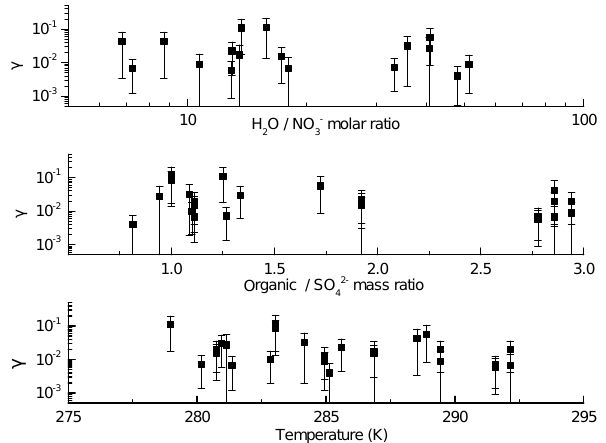
Figure 10. Plot of γ and temperature, molar ratio of particle H 2 O to particulate nitrate and the particle organic-to-sulfate mass ratio. Error bars are total uncertainty, calculated as described in the